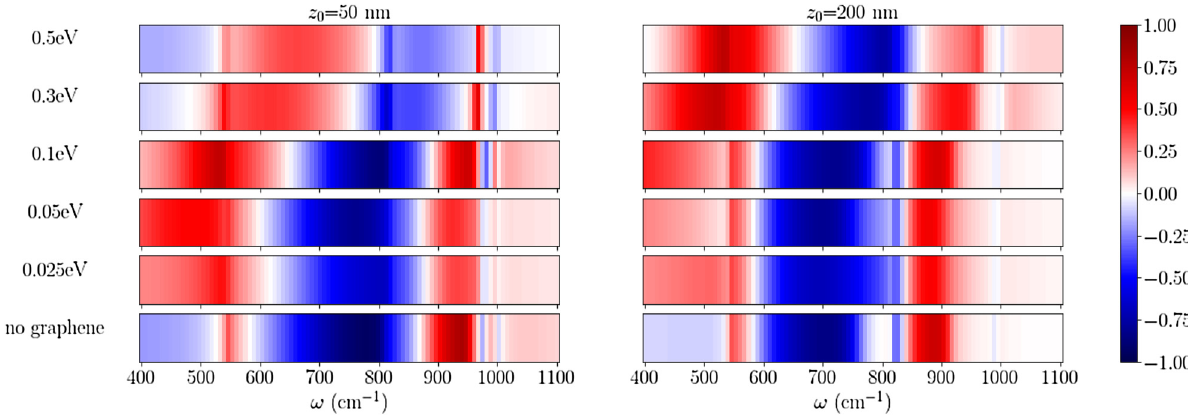
Figure 5: Quantum interference ( Q ) for air/graphene/MoO 3 /Si heterostructure with MoO 3 thickness of 50 nm, plotted as a function of frequency,fortwodifferentdipoleheightsof z 0 =50and200nm,respectively.Thecolorbarrepresentsunitlessquantityquantuminterference ( Q